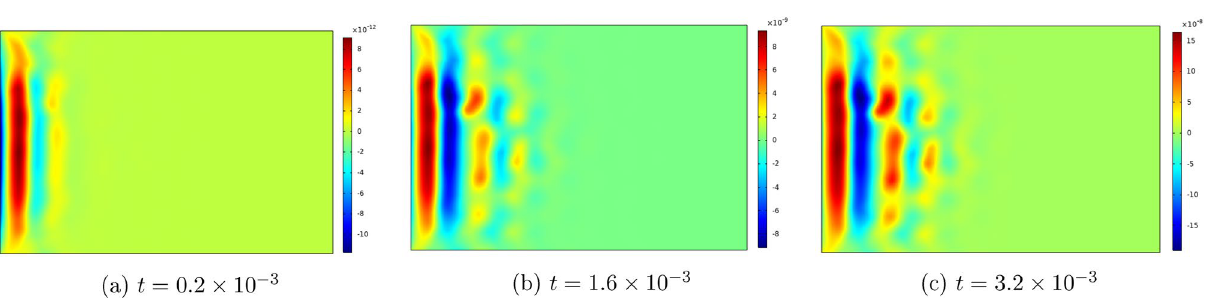
Figure 7. Top view of the distribution of q x in the slab at three consecutive time moments.